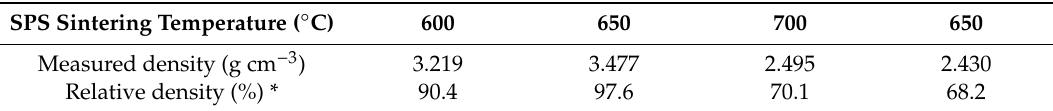
Table 1. Comparison of the measured densities and the relative densities of LAGP sintered by SPS method at di ff erent temperatures.